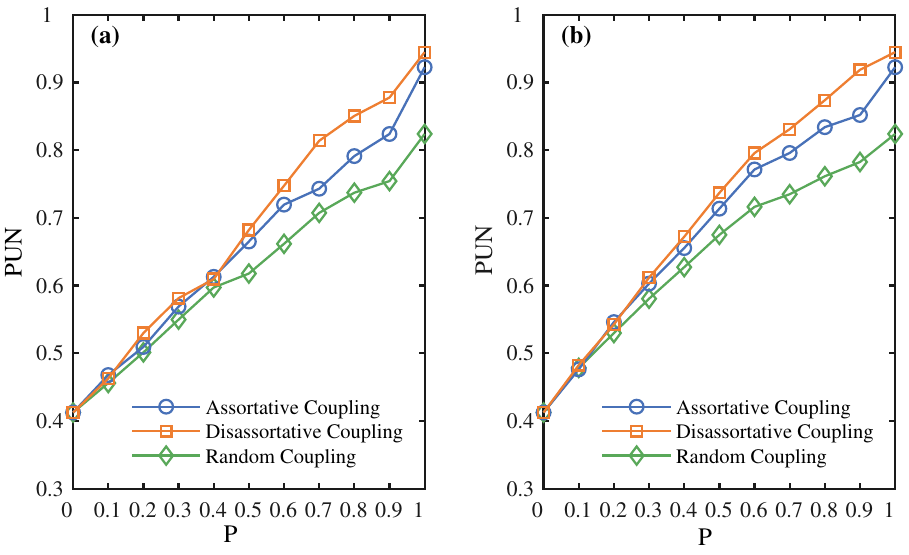
Figure 3. Robustness of CPS changes as a function of failure propagation P under three coupling modes. ( a ) Node–Node propagation; ( b ) Node–Link